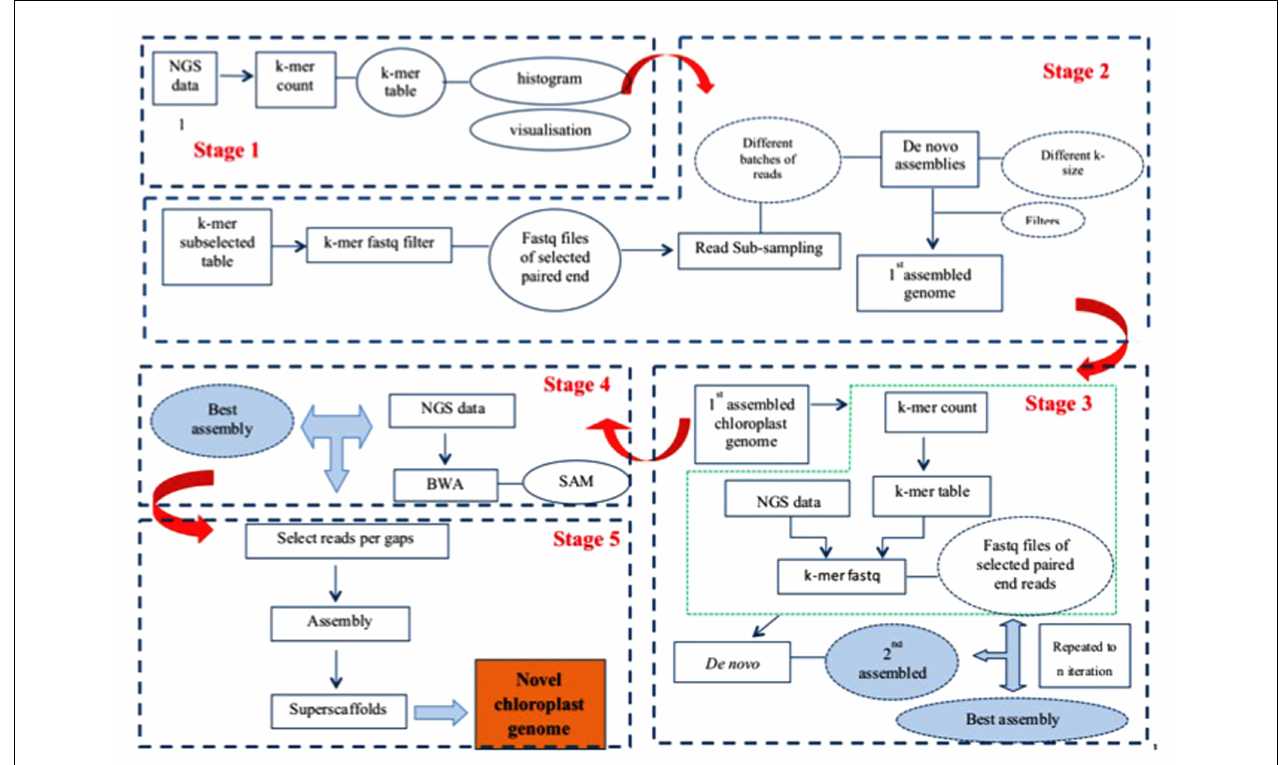
FIGURE 1 | Workflow of our assembly